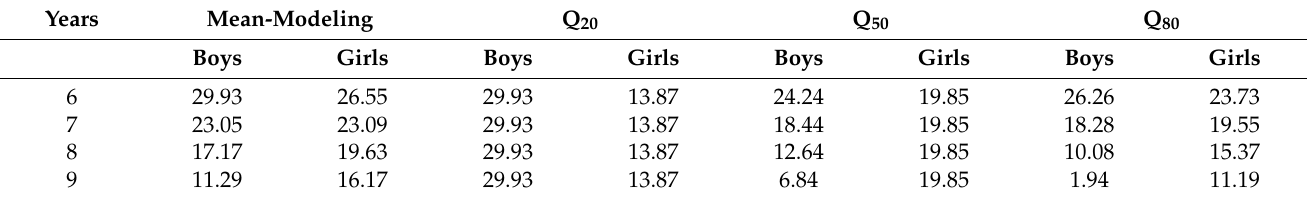
Table 3. Gross motor coordination estimated rates of change ( ∆ cg ) expressed as points · y − 1 in both boys and girls with the mean-modeling versus the quantile